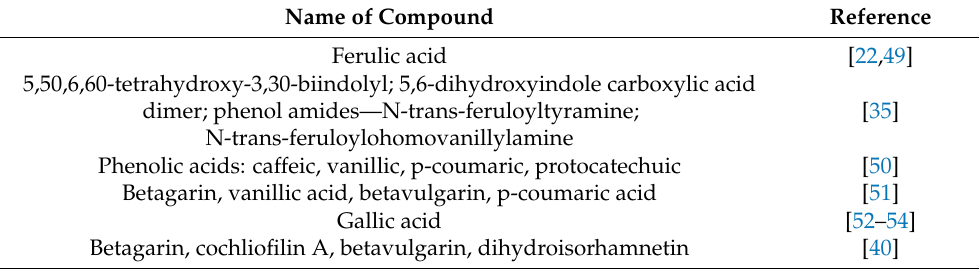
Table 1. Phenolic compounds in beetroots.